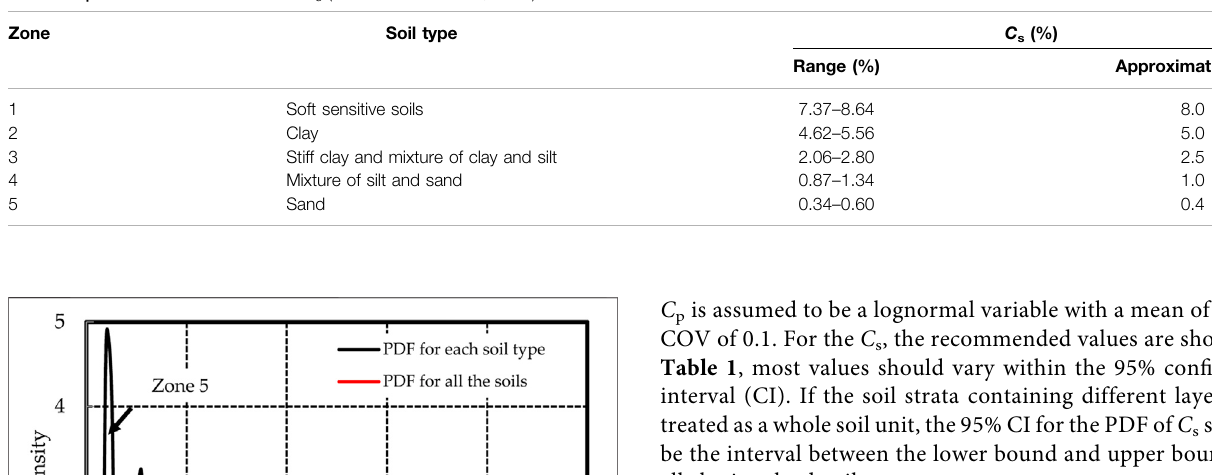
TABLE 1 | Shaft correlation coef fi cient C s (Eslami and Fellenius, 1997).